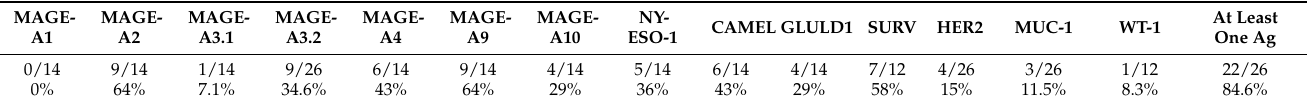
Figure 3. Specific T-cell responses according to NSCLC subtypes. ( A ) Proportion of patients responding to more than one antigen. ( B ) Number of antigen-specific T-cell responses per patient according to their histopathology subtype. Each circle represents a patient. The mean is shown as +/ − standard deviation. AC—adenocarcinoma; SCC—small cell carcinoma. ( C ) Proportion of patients with specific T-cell responses in the two groups of patients. Table 2. Proportions of patients responding to tumor antigens